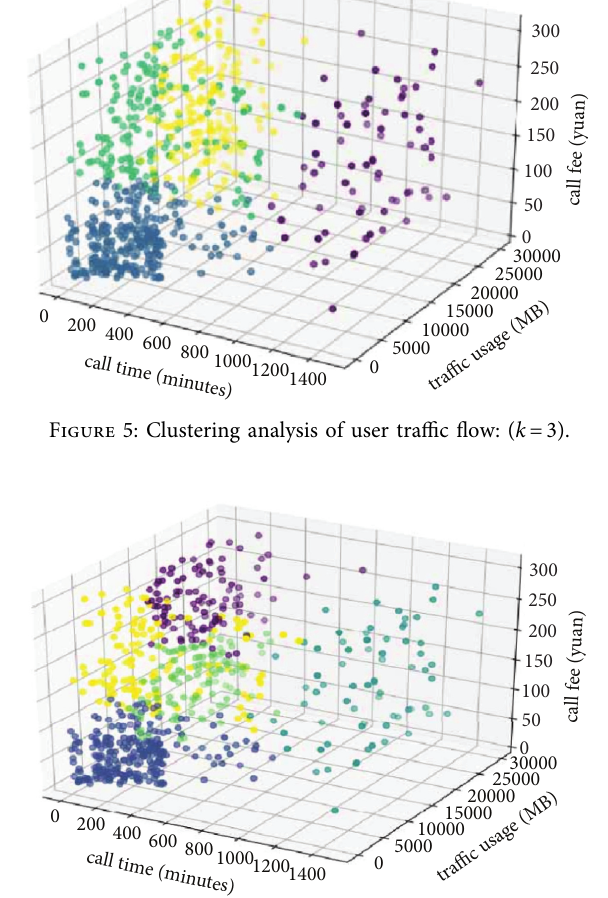
Figure 6: Clustering analysis of user traffic flow: k � 4.